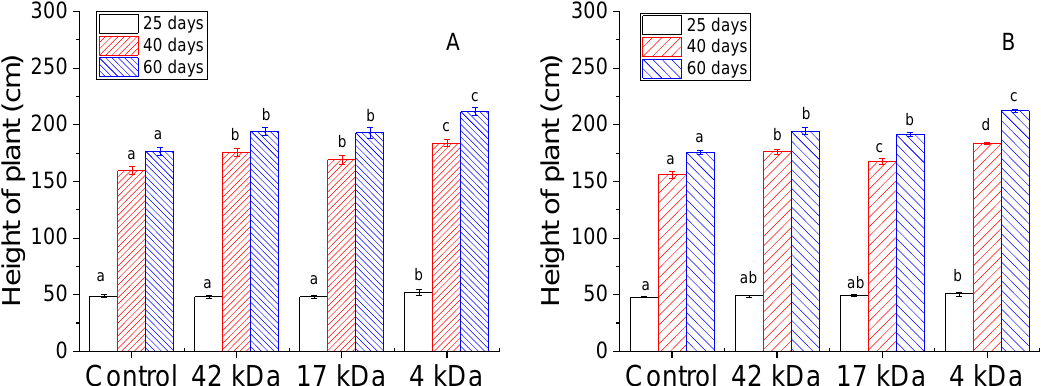
Figure 3. Influence of MWs on height of maize plant collected in 2018 ( A ) and 2019 ( B ). Bars represent mean values of three replicates ± standard deviation. Different letters indicate significant differences ( p < 0.05).